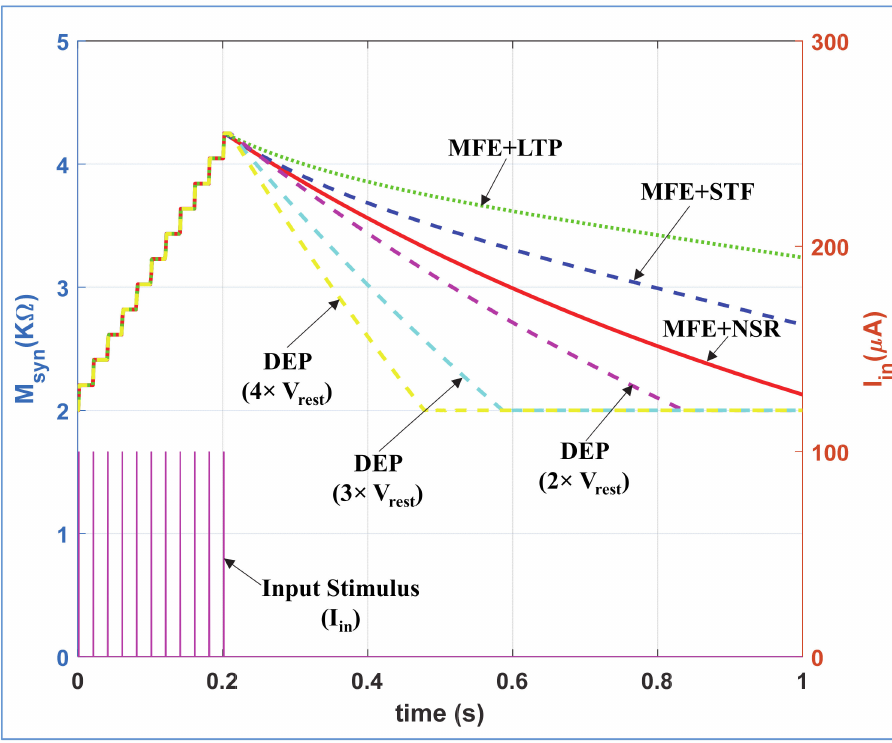
Figure 6. Comparison of synaptic weakening (M syn ) between the different modes of proposed neuro-memristive